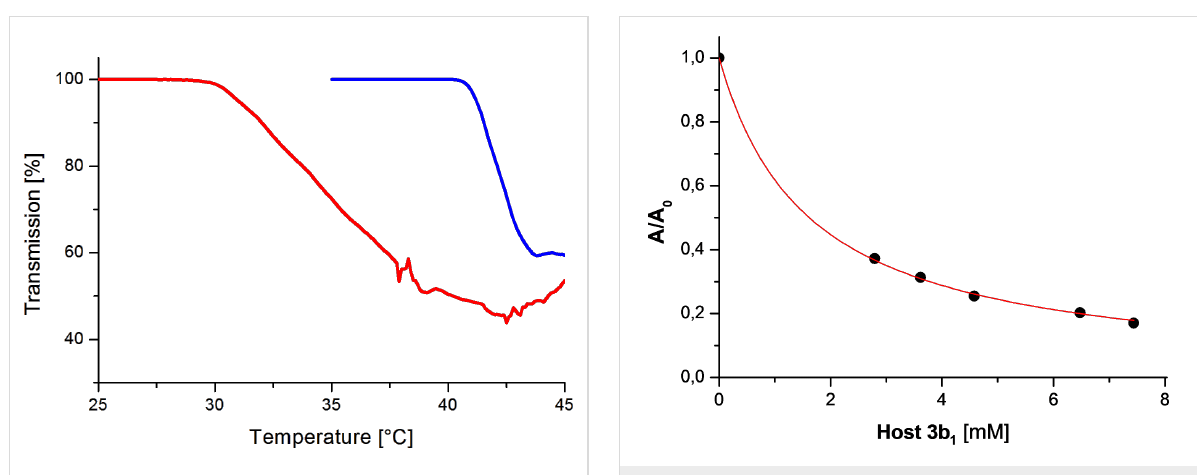
Figure 4: Decay of the relative vapour pressure A / A 0 as function of the host concentration 3b 1 measured by GC headspace; the curve was fitted according to Equation